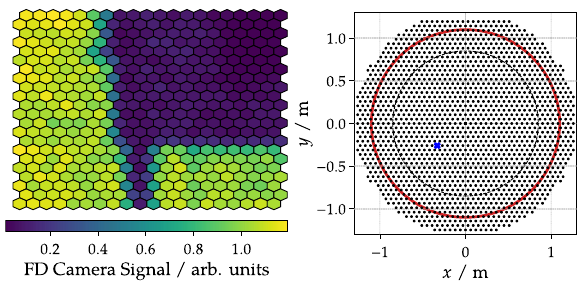
Figure 4. Left: an example of a signal detected at each PMT pixel for a single position of the calibration light source. The shadow of the camera and supporting structure are clearly seen. The position of the light source is marked as a blue spot on the right side of the figure. Right: a triangular grid (black dots) of all positions of the calibration light source at the FD telescope aperture.